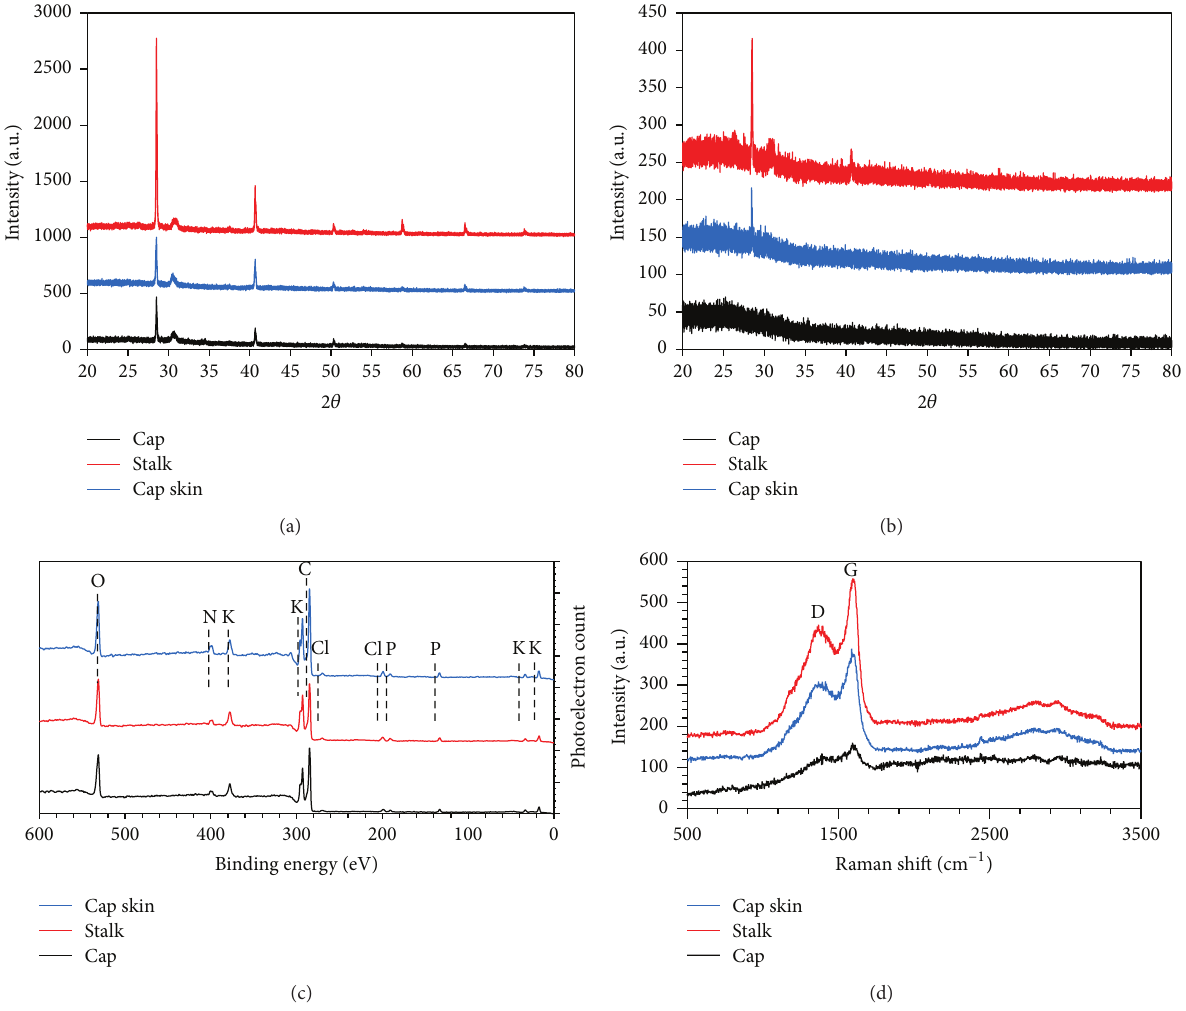
Figure 5: Spectral data from CT (cap), ST (stalk), and CST (cap skin), including XRD spectra from pre-DI H 2 O wash (a), post-DI H 2 O wash (b), XPS of pristine, unwashed samples (c), and Raman spectra of washed CT, ST, and CST samples